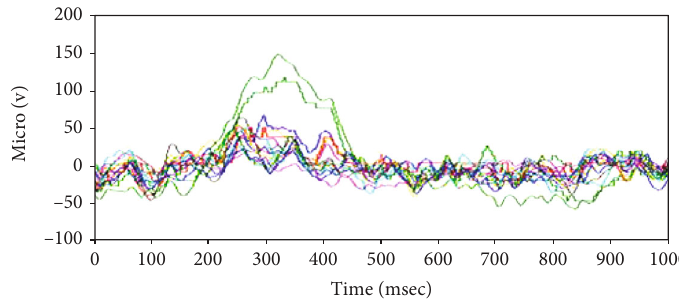
Figure 5: Time series for subject at the half seconds in the case of open eyes.